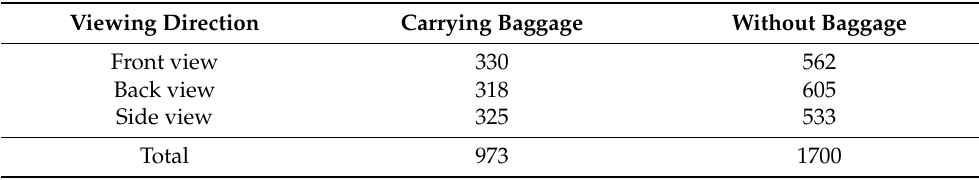
Table 10. PETA dataset distribution for multi-classification for the first experiment.